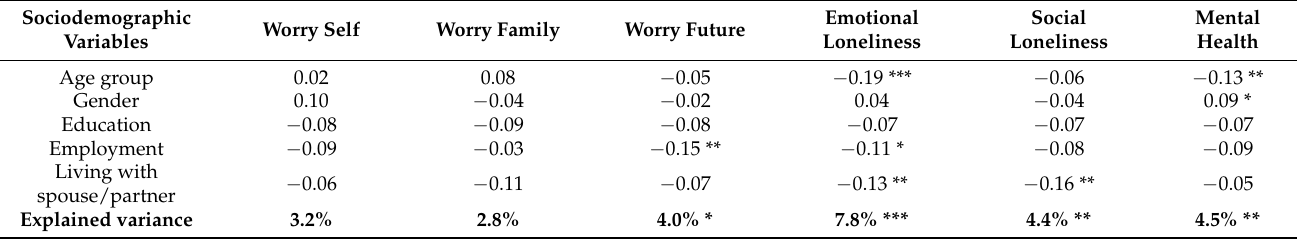
Table 3. Standardized β weights of adjusted associations between sociodemographic factors and worrying, loneliness, and mental health among participants with infection ( n =